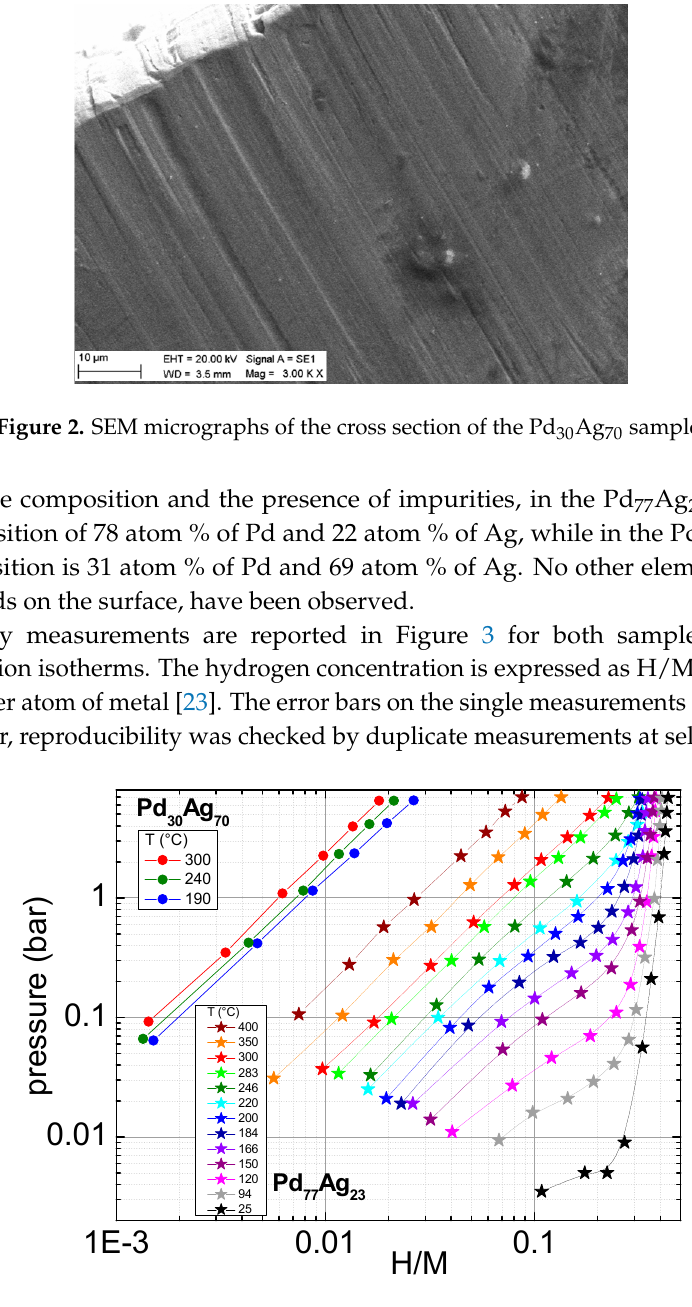
Figure 3. Absorption pressure–composition isotherms measured at selected temperatures for Pd 77 Ag 23 and Pd 30 Ag 70 .